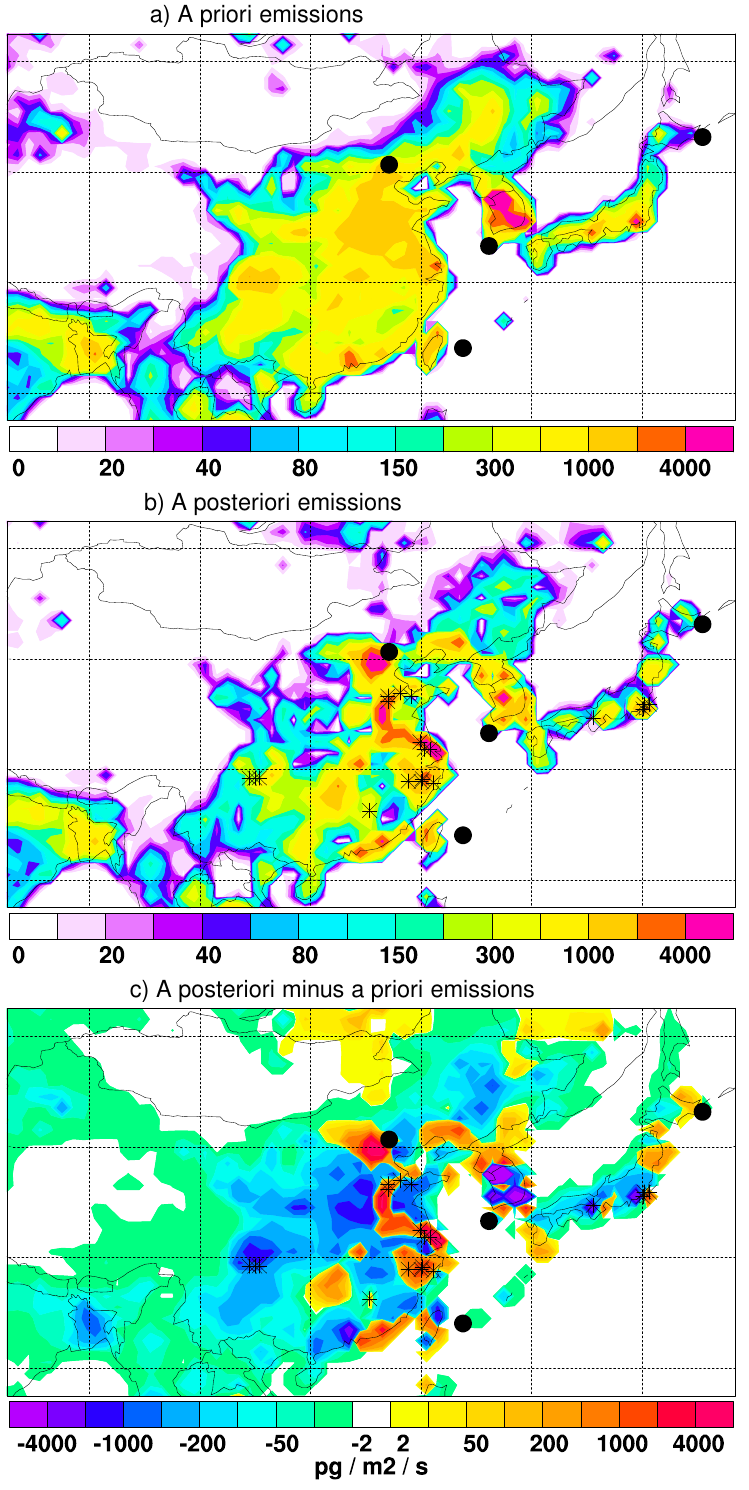
Fig. 3. Maps of the a priori (a) , a posteriori (b) , and difference between a posteriori and a priori (c) HCFC-22 emissions in picogram per square meter and second for the year 2008. Black dots indicate the location of measurement stations, asterisks in panels (b) and (c) mark the locations of Chinese and Japanese factories known to have produced HCFC-22 in the year 2008. This information was not used in the